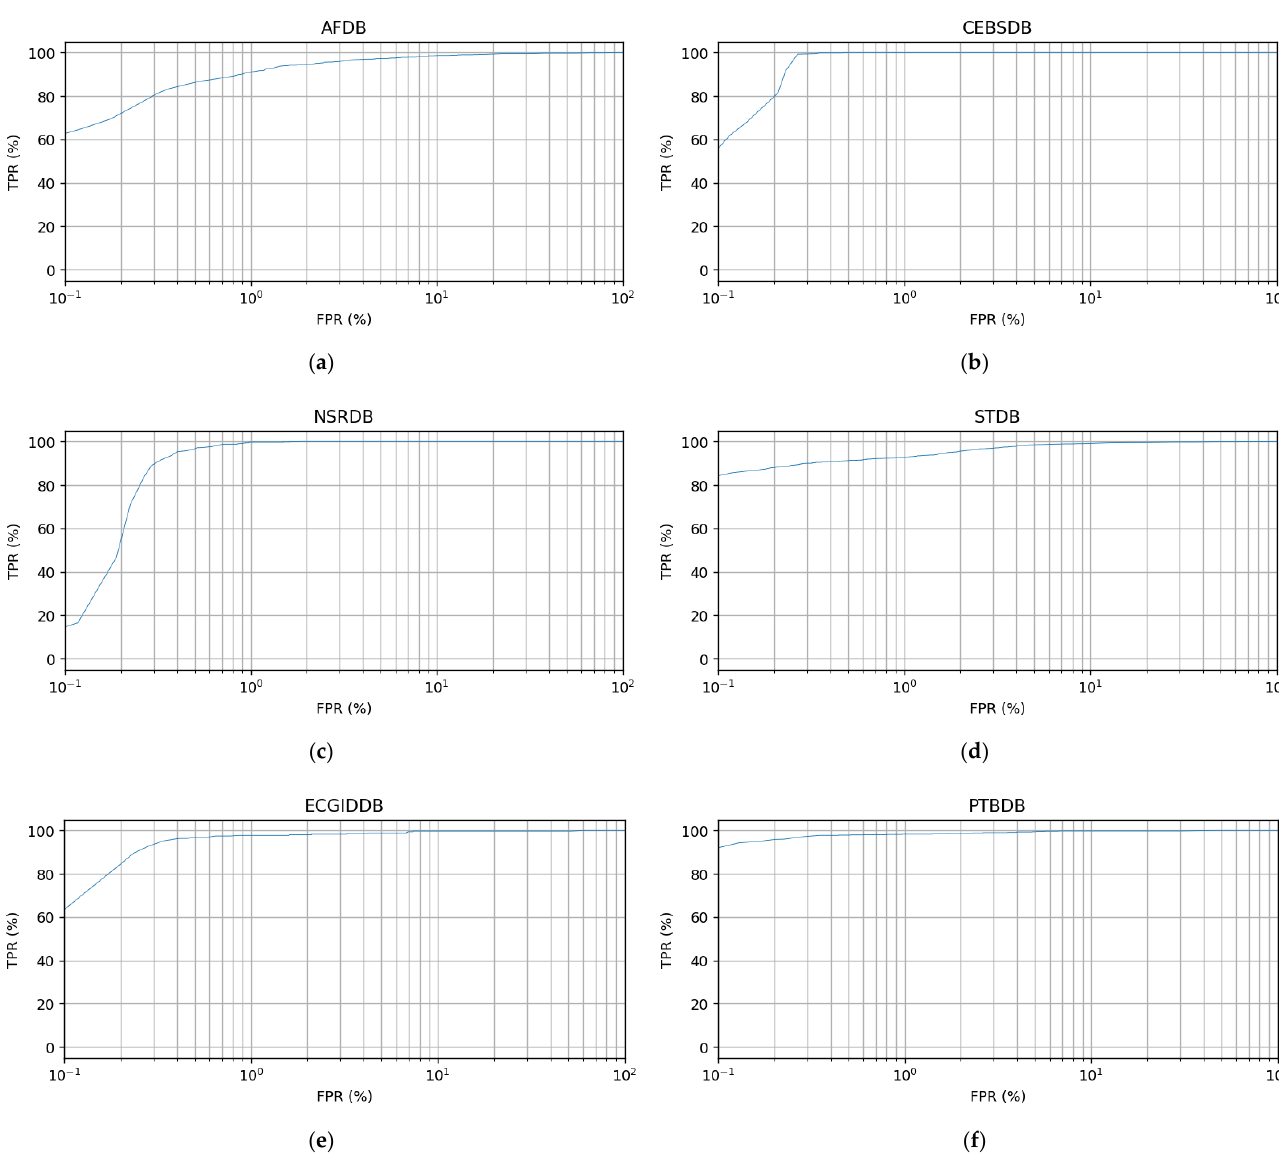
Figure A1. ROC curves are used to evaluate the individual verification performance tested over short time separation for: ( a ) AFDB, ( b ) CEBSDB, ( c ) NSRDB, ( d ) STDB, ( e ) ECGIDDB, ( f ) PTBDB.